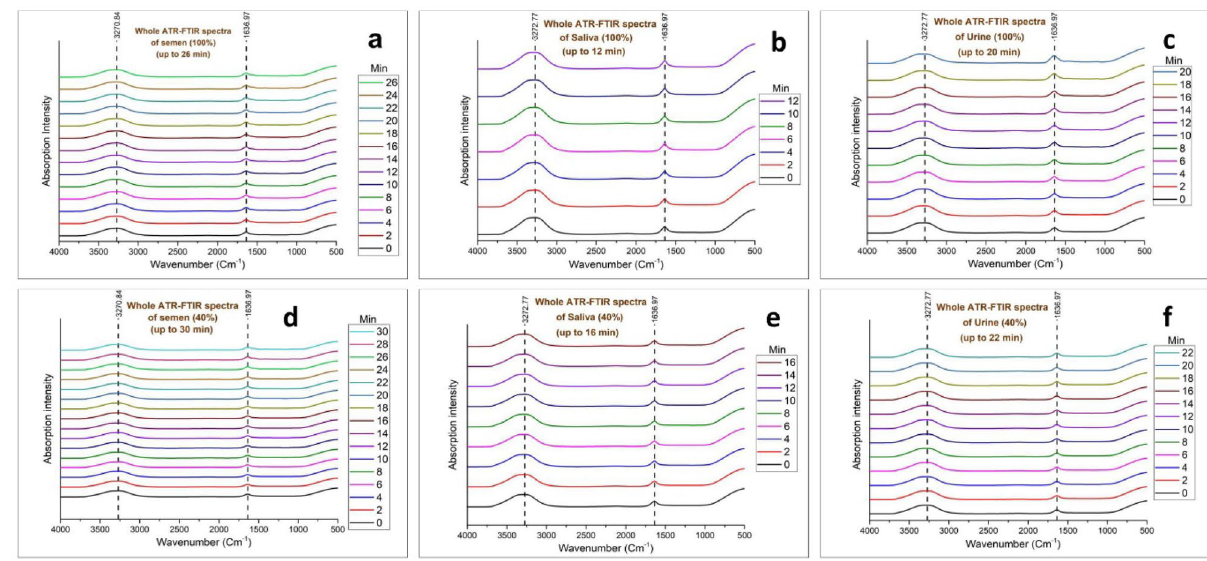
Figure 1. Whole ATR FTIR Phase I spectra for ( a ) 100% semen, ( b ) 100% saliva, ( c ) 100% urine, ( d ) 40% semen, ( e ) 40% saliva, ( f ) 40% urine.